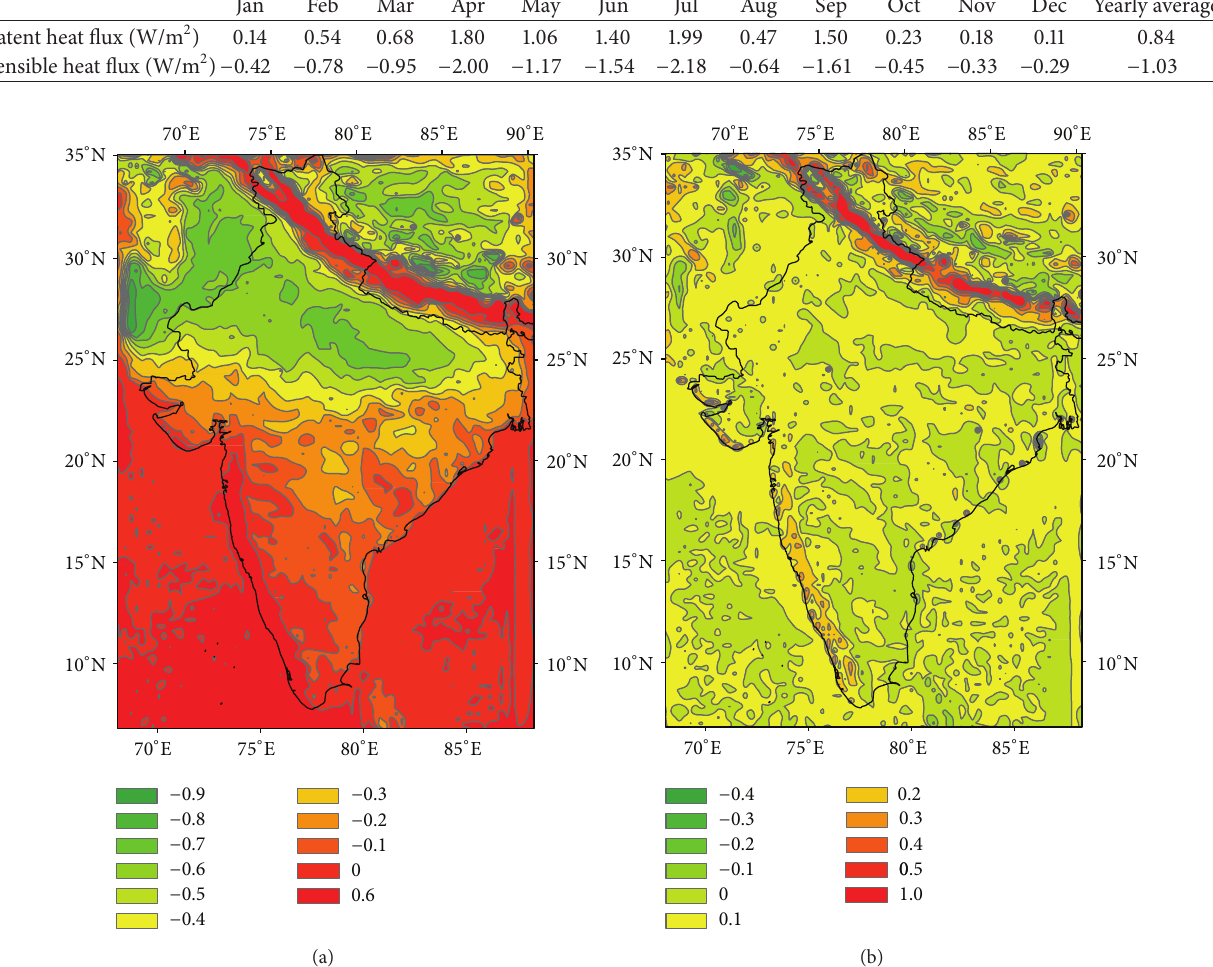
Figure 3: Change of the monthly average temperature in the summer (a) and the winter (b) due to the cultivated land reclamation in